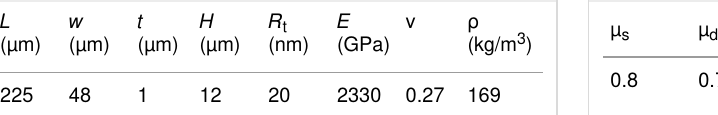
Table 2: Tribological parameters between particle/tip and needle/sub- strate